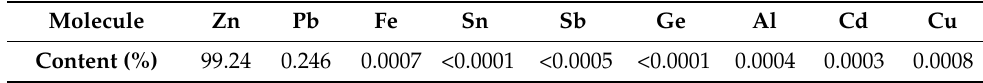
Table A1. Chemical analysis of the composition of zinc dust.